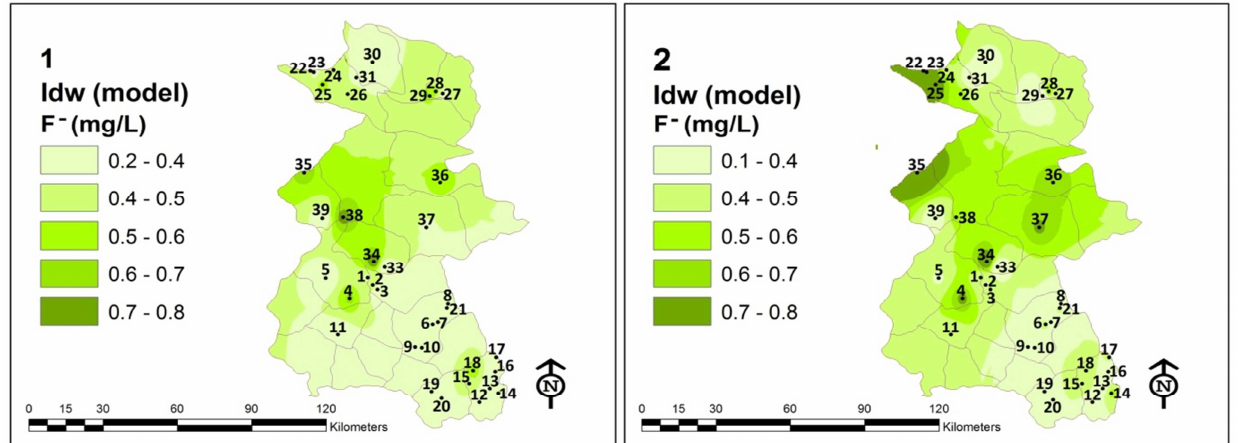
Figure 2. Spatial distribution of fluoride in groundwater in low and high water seasons According to the finding of Govardhan Das, water with fluoride concentration of higher than 1.5 mg/l has a hardness of lower than